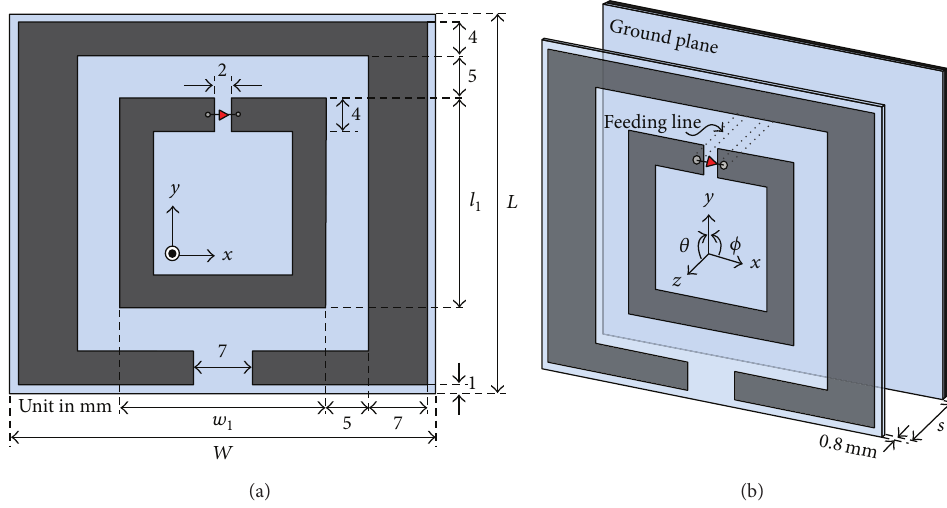
Figure 1: Geometry of the proposed antenna with ground plane: (a) front view and (b) perspective view.